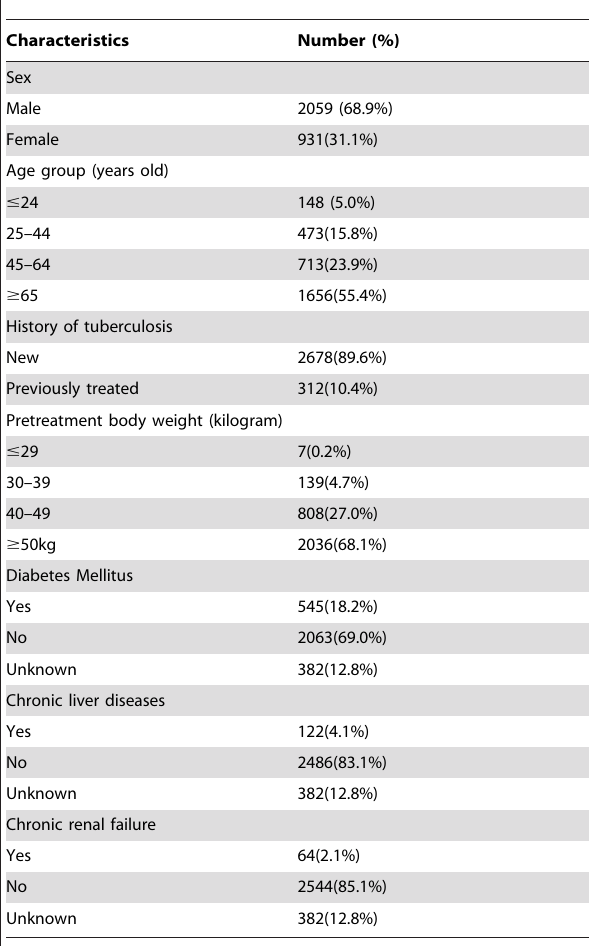
Table 1. Characteristics of 2990 adults with pre-treatment body weight.